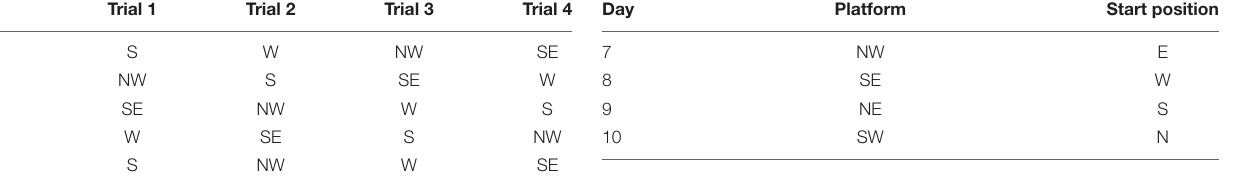
TABLE 3 | Real-time PCR